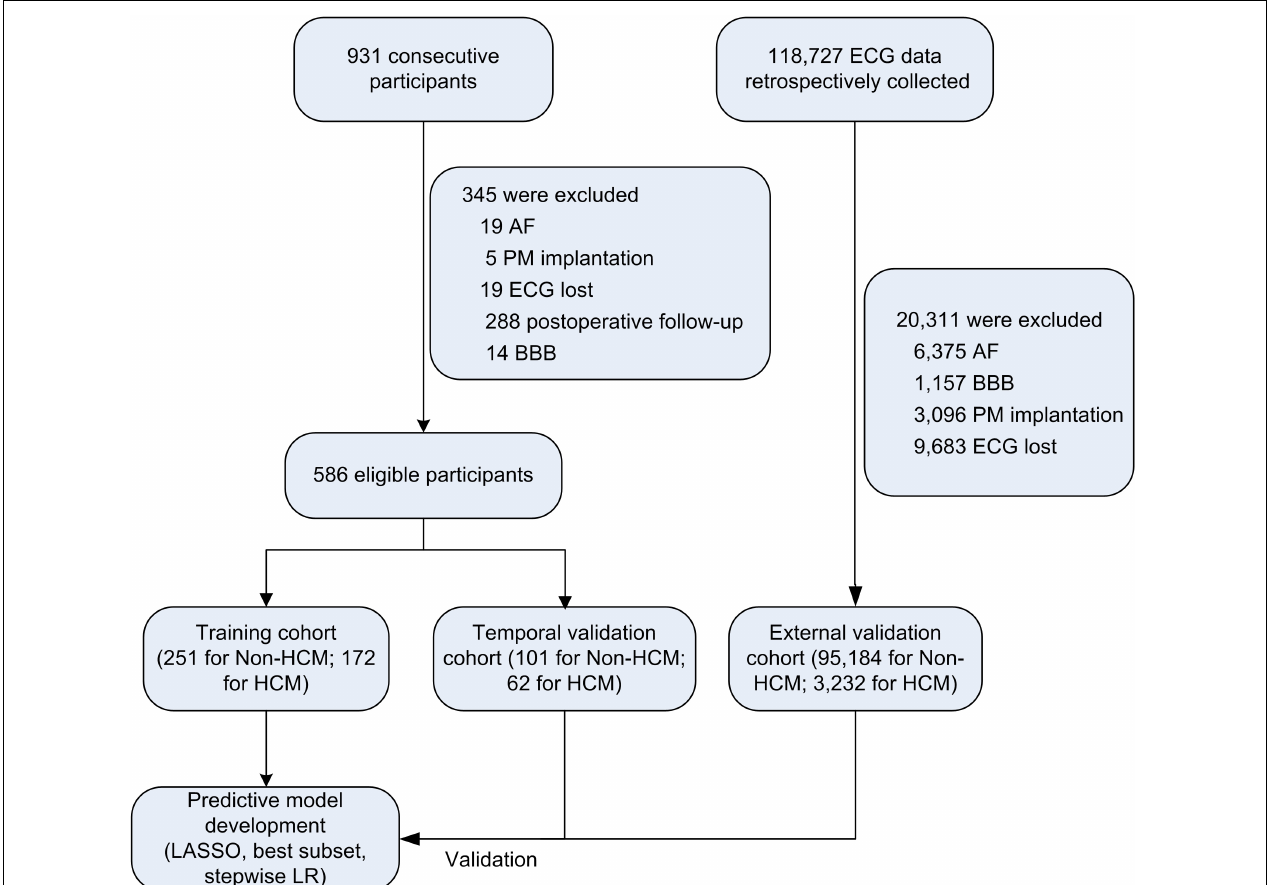
FIGURE 1 | Study flow chart. AF, atrial fibrillation; PM, pacemaker; BBB, bundle branch block; HCM, hypertrophic cardiomyopathy; LASSO, the least absolute shrinkage and selection operator; LR, logistic regression.